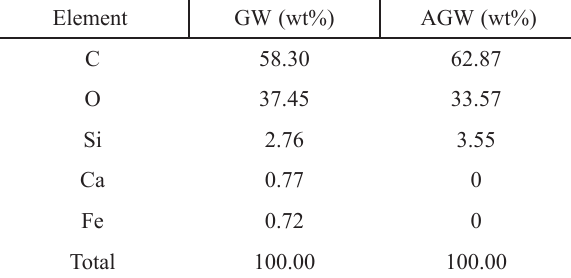
Table 1 – Elemental composition of GW and AGW obtained by spot analysis through EDX Element GW (wt%) AGW (wt%) C 58.30 62.87 O 37.45 Si Ca 0.77 Fe 0.72 0 Total 100.00